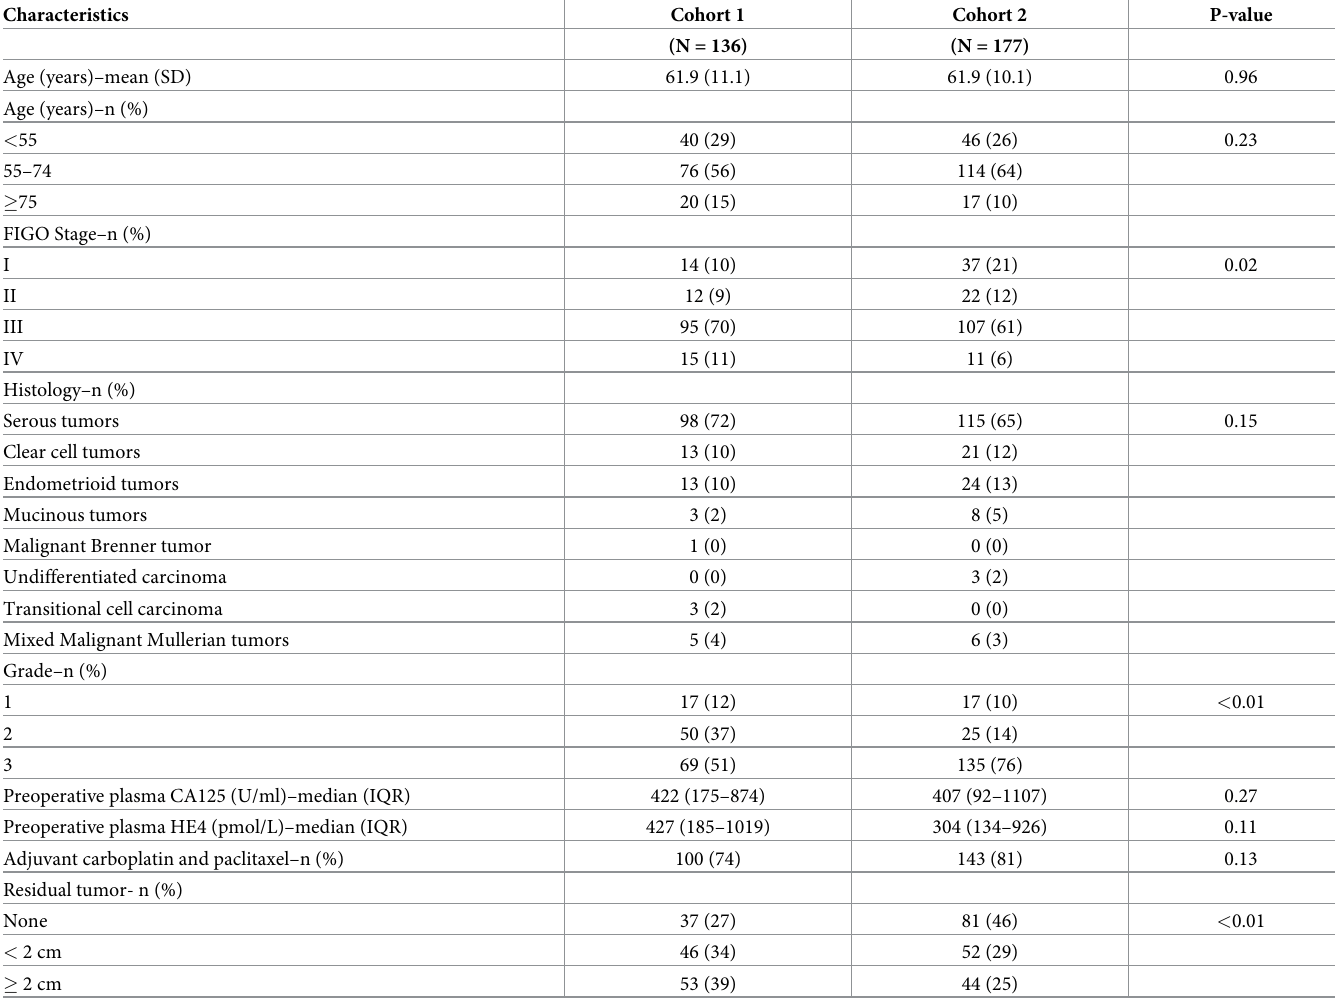
Table 1. Clinical characteristics of women with epithelial ovarian